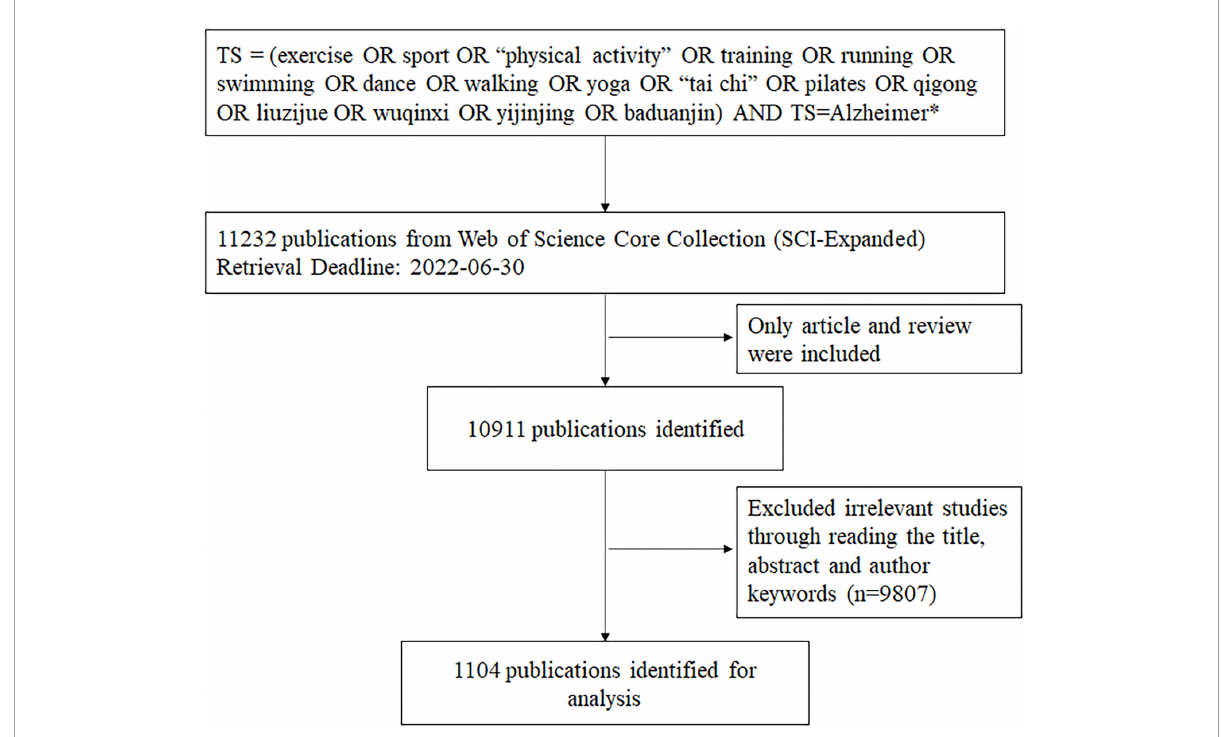
FIGURE1 Flow diagram of the publications screening